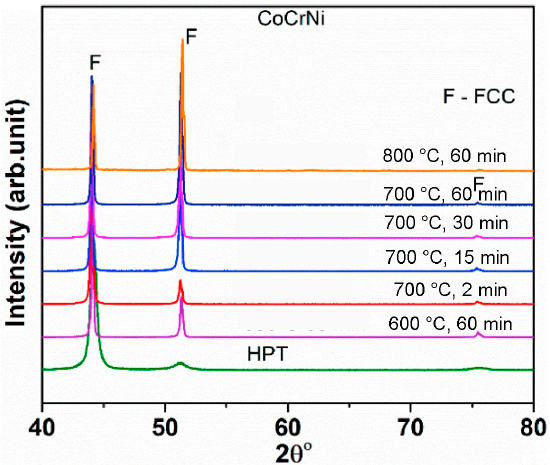
Figure 14. XRD patterns of CoCrNi alloy in different processing conditions illustrating the presence of a single fcc phase. Reprinted with permission from Ref. [146]. Copyright 2018 MDPI.